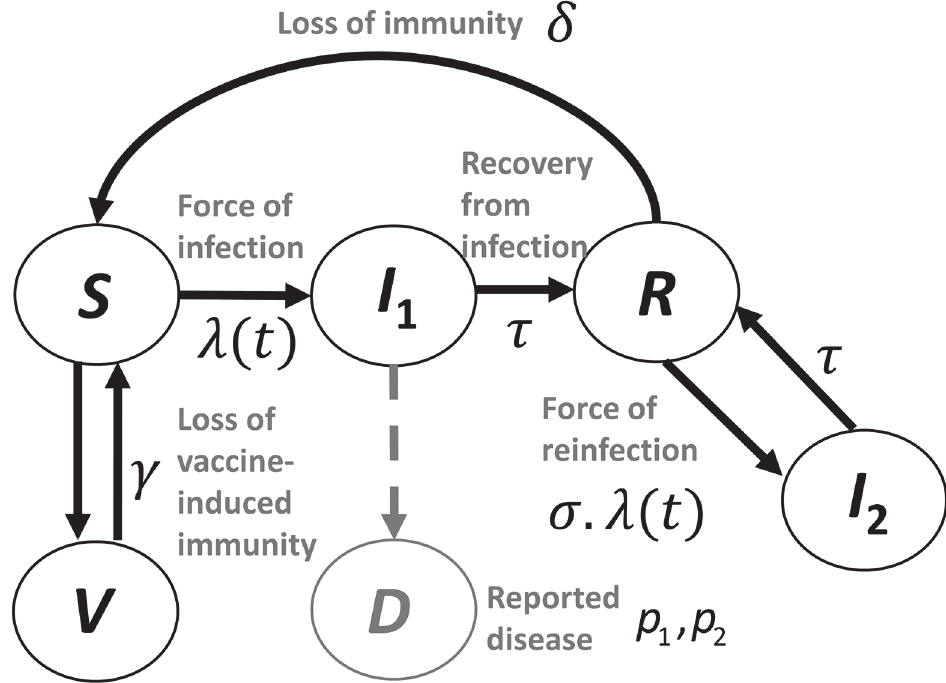
Fig 5. Epidemiological model diagram. The compartmental model for pertussis infection and disease used, modified from the basic model of Aguas et al [44]. There are two infected compartments for primary ( I 1 ) and secondary (or higher) infection ( I 2 ). We assume that surveillance systems only capture those who are experiencing primary infection. Once an individual has recovered from primary or secondary infection, induced immunity may wane, whereupon they will re-enter the susceptible state. Rates of flow between compartments are defined in Table 3.